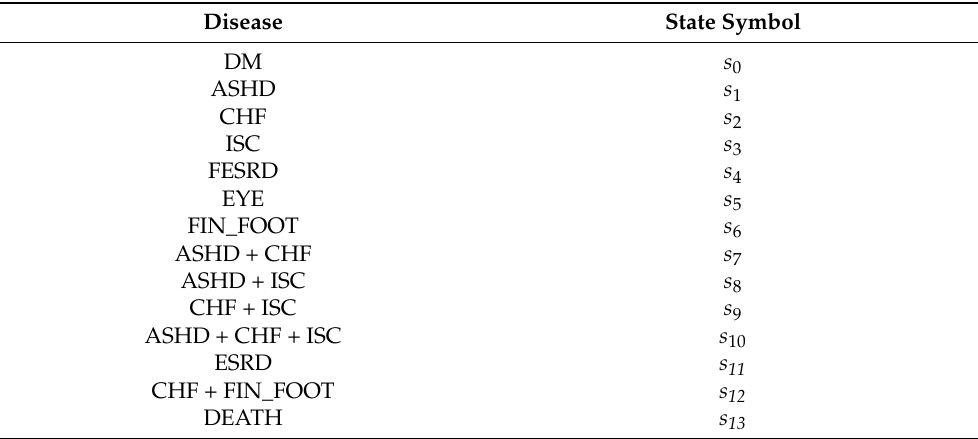
Table A1. Symbols of the states.